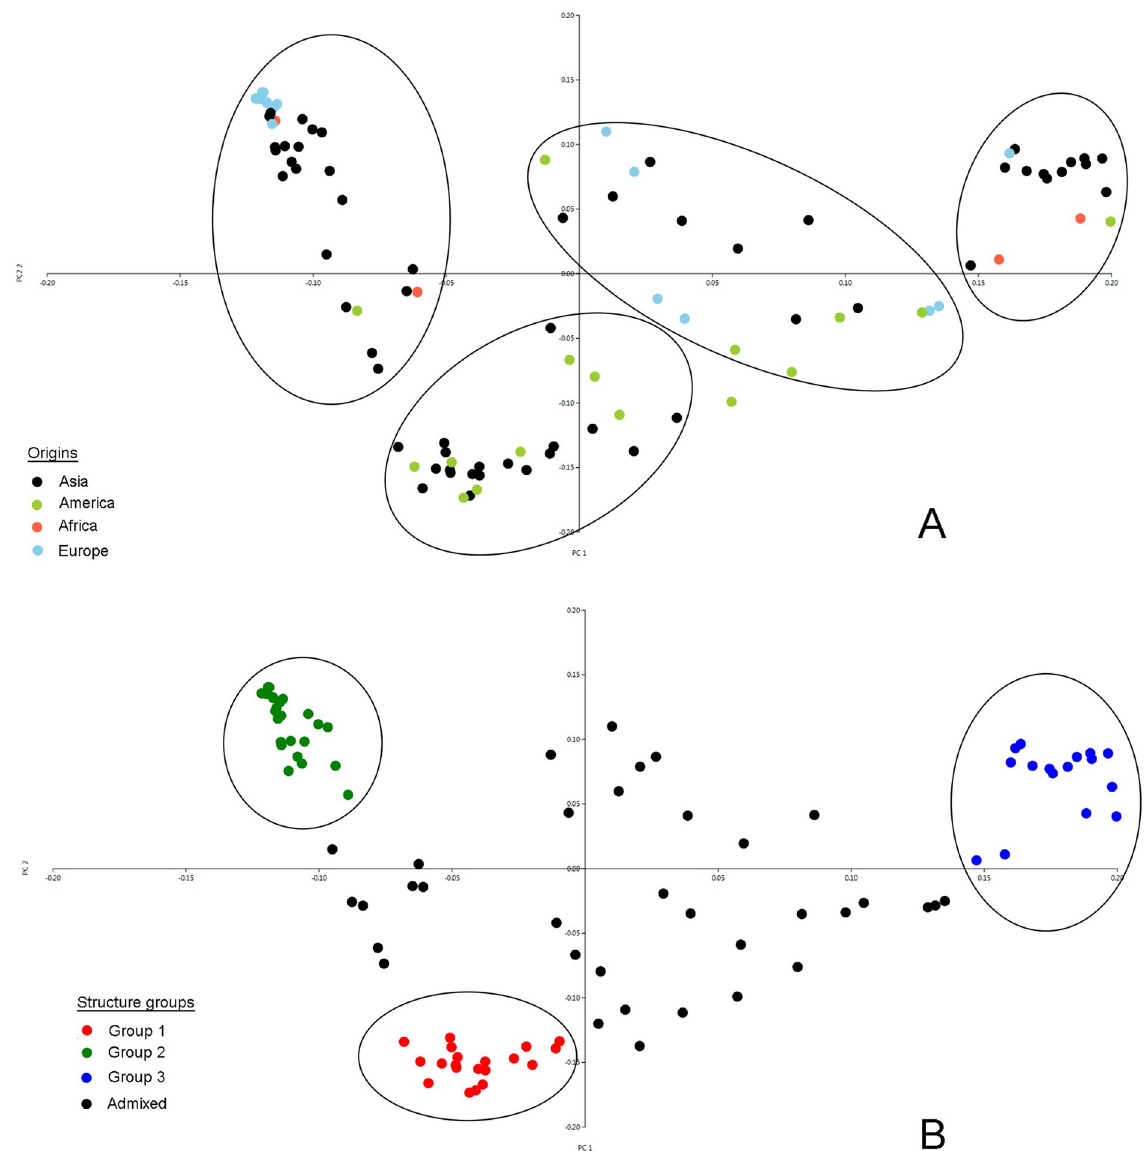
Fig 3. (A) Principal coordinate analysis (PCoA) of 95 sesame accessions based on 5292 SNP markers. Colors reflect continental origin of accessions. (B) PCoA separated by group membership in STRUCTURE at K = 3. Circles have > 80% membership colored red, green and blue circles; black circles are admixed at rate of <